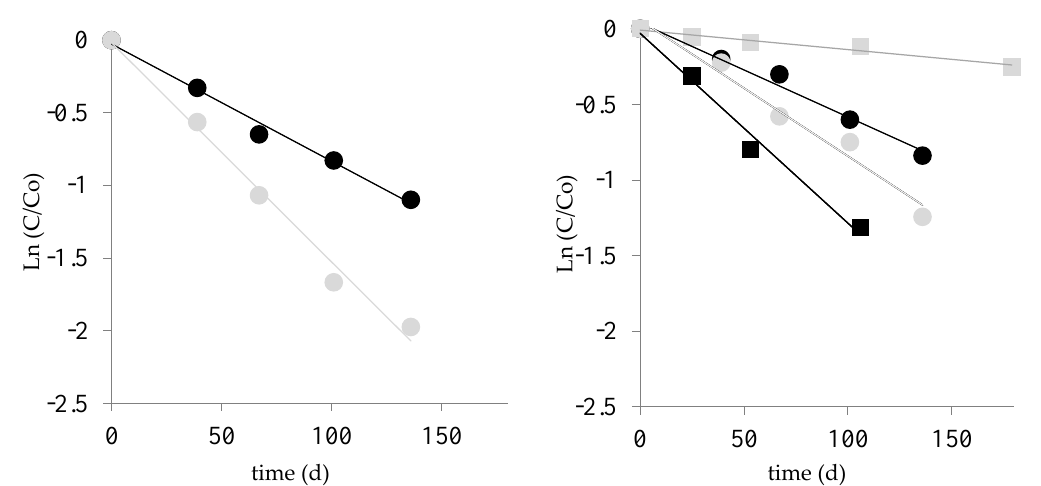
Figure 2. Time course of lycopene (circle) and chlorogenic acid (square) degradation in tomato pulp powder (black line and symbols) and tomato pulp powder added with MD (grey line and symbols) during storage at a w 0.17 (on the left) and 0.56 (on the right). Symbols represent experimental data; lines represent fitting experimental data with first-order kinetics. Table 2. Initial concentration (mg/kg dry weight), storage temperature ( ◦ C), time (d), a w , first-order rate constant (d − 1 ) and half-life (d) of lycopene in various matrices. Matrix Co T t a w k × 10 3